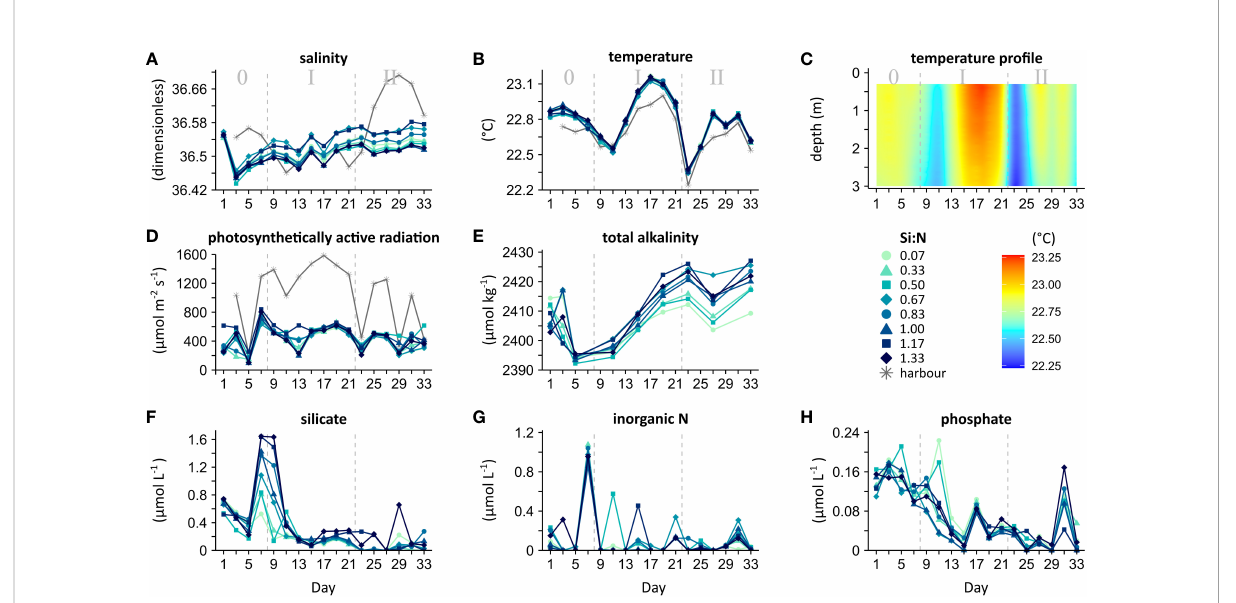
FIGURE 3 Environmental conditions and nutrient concentrations in the mesocosms. In situ measurements with averages from 0.3 to 2.5 m depth for each mesocosm (A, B, D) and a vertical pro fi le averaged across all mesocosms (C) . Laboratory measurements of integrated water samples from 0 to 2.3 m depth (E-H) . Experimental phases: 0 = oligotrophic baseline, I = initial response, II = longer-term